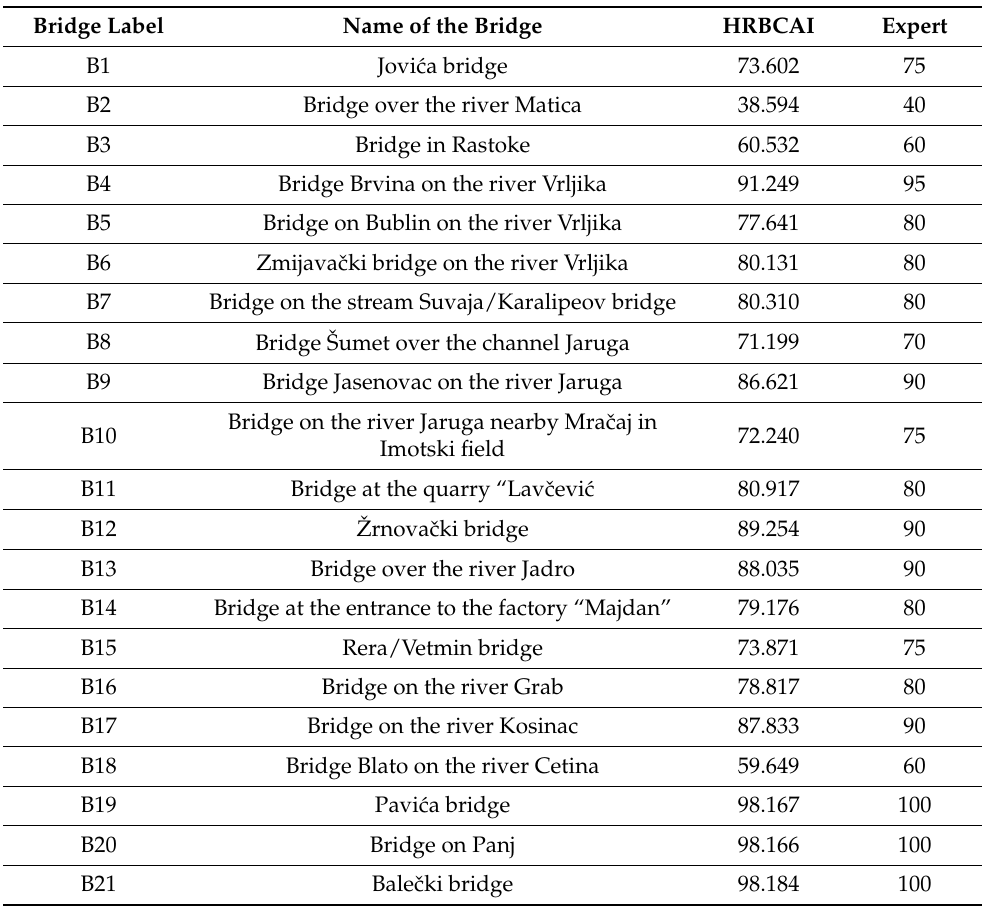
Table 16. Historic Road Bridge Condition Assessment Index (HRBCAI) values for historic road bridges values obtained by the proposed model and their comparison with the values given by the